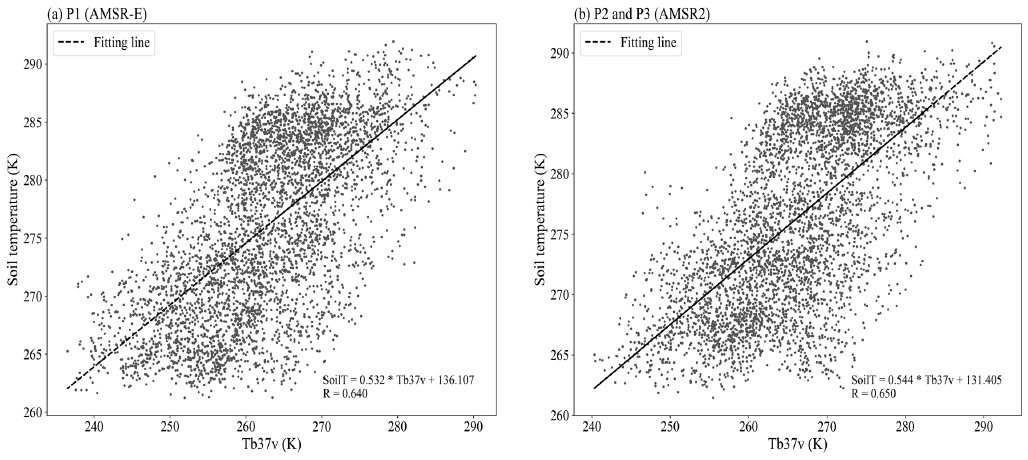
Figure 4. The linear relationship between soil temperature and Tb37v over the periods of P1 ( a ) and P2, P3 ( b ).